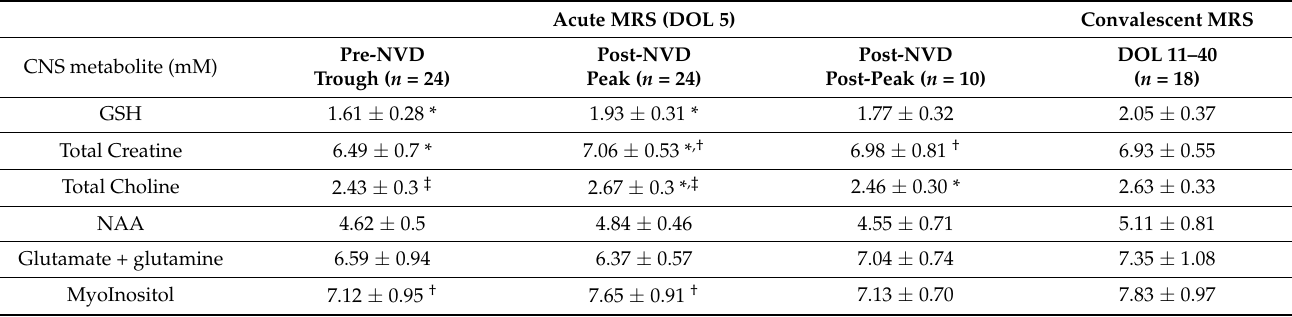
Comparing MRS metabolites over 3 scans during the acute HIE phase, before and after NVD infusion on DOL5, intent to treat analysis: overall ANOVAs are significant for GSH ( p = 0.012), tCr ( p = 0.005), tCho ( p = 0.001); mIns ( p = 0.009). Specific groups that were significantly different by pairwise comparisons are noted by * p < 0.05, † p < 0.005, ‡ p <